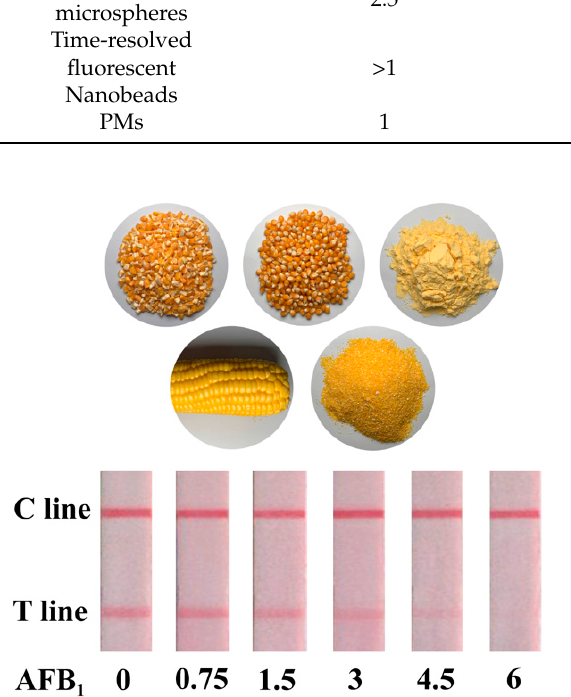
Figure 3. The sensitivity of PMs-ICA for detection of AFB 1 in PB. Result for AFB 1 standard of differ- ent concentrations, by the naked eye, and calibration curve of B/B 0 against the concentration of AFB 1 .